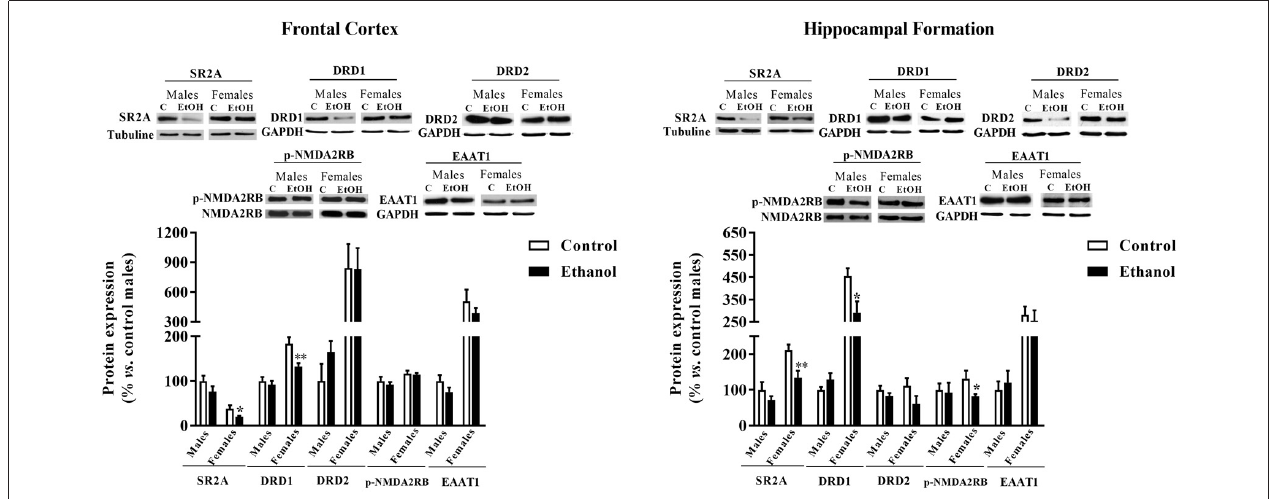
FIGURE 7 | Expression of some markers of serotoninergic, dopaminergic and glutamatergic neurotransmission. Protein expression levels of serotoninergic receptors (5HT2A y 5HT2B), dopaminergic receptors (D1R and D2R), pNMDA2RB and EAAT1 in the FC (left panels) and the HF (right panels) of adult male and female rats that were exposed to a ethanol (20% in drinking water) or tap water for 2-h sessions during 3 days, and for an additional 4-h session on the 4th day, every week during adolescence, from pnd 28–52. Histograms (mean ± SEM) represent the protein levels expressed as values of optical density calculated as changes from the control male group (%). t -Student, ∗ p < 0.05, ∗∗ p < 0.01 compared with the corresponding control group. n = 5–8 per experimental group, coming from four litters.